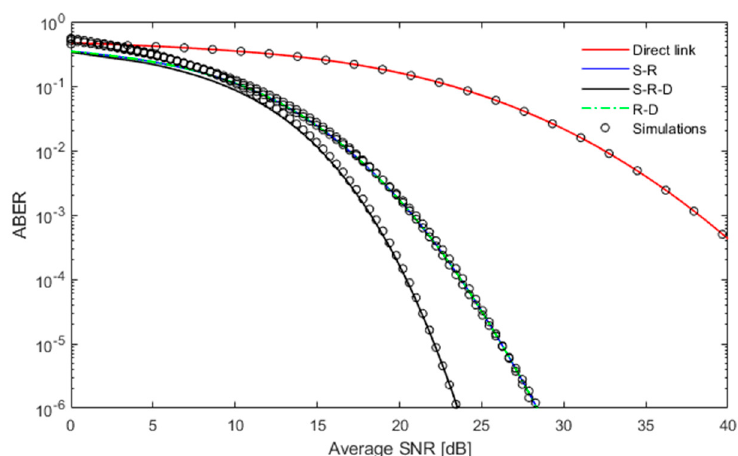
Figure 6. ABER vs. SNR of FSO over L-N channel for moderate turbulence with distance 500–500 m, the number of relays = 3, and w z = 2 m.